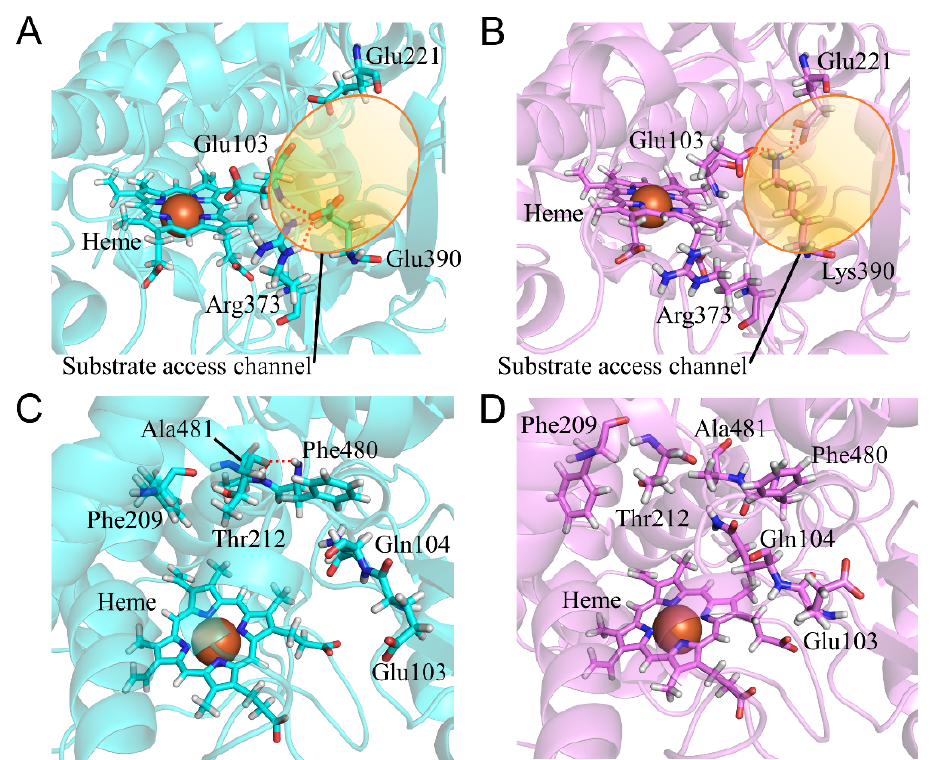
Figure 12. Structural change in CYP2A6.44 ( A – D ). The wild type and CYP2A6.44 are shown in cyan and purple, respectively. Nitrogen, oxygen, and hydrogen are displayed in blue, red, and white, respectively, in the stick model. Iron is shown as an orange sphere by a model written as van der Waals radius. The red dotted lines indicate the hydrogen bonds.